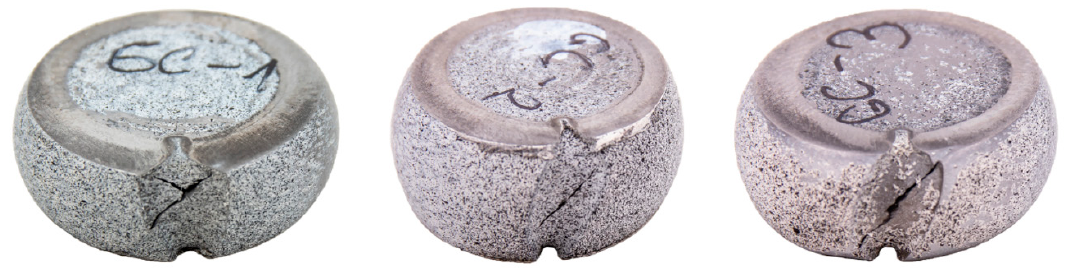
Figure 14. Notched cylinder specimens after testing with fractures in the notch region.